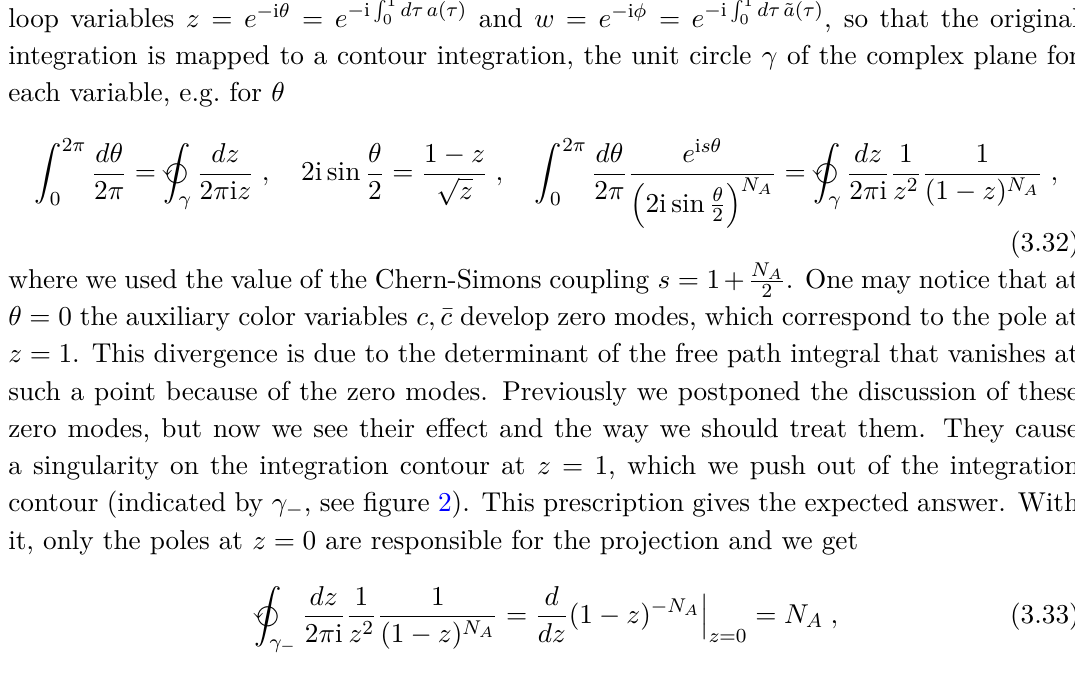
Figure 1 . Self-energy contribution to the bi-adjoint propagator at